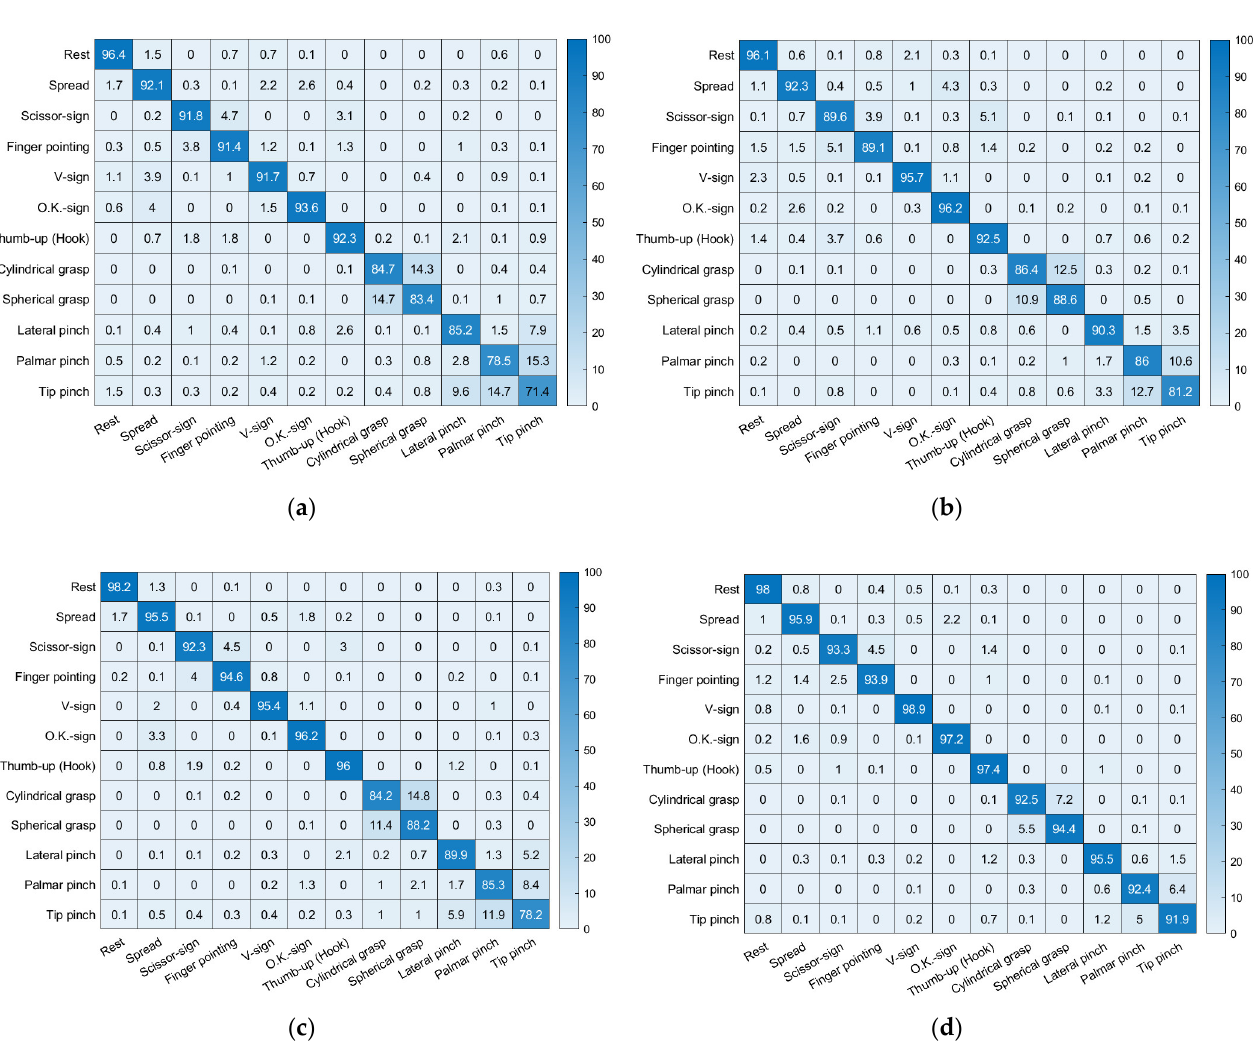
Figure 10. Confusion matrixes for the healthy adults: ( a ) Day 1 with MAV only, ( b ) Day 2 with MAV only, ( c ) Day 1 with Hudgins’ set, ( d ) Day 2 with Hudgins’ set.